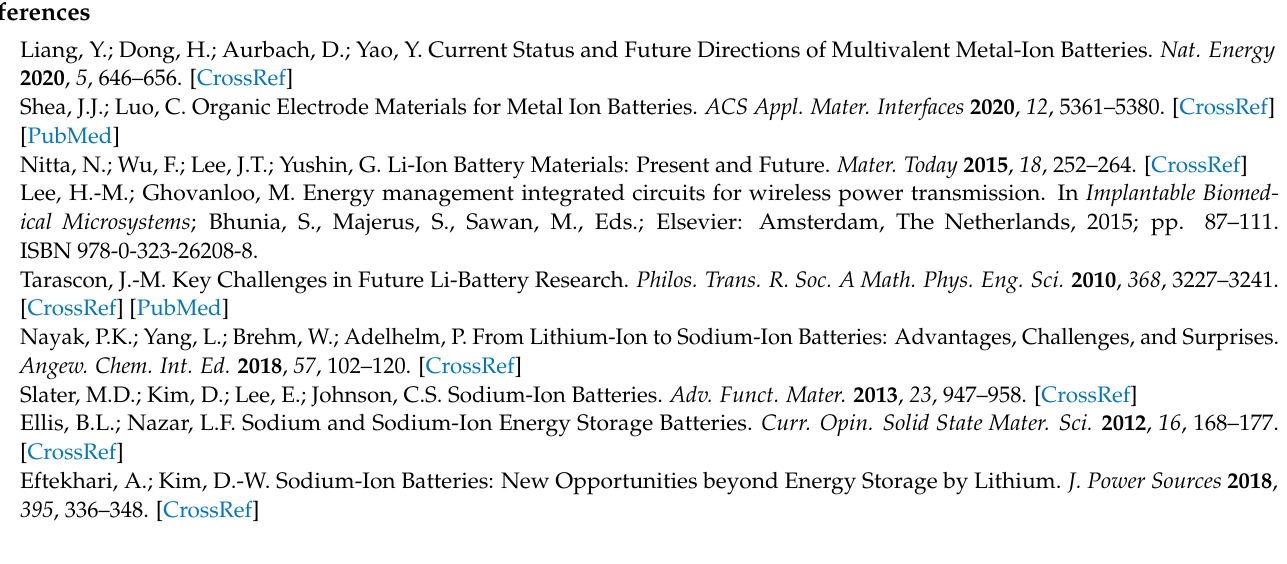
Figure S2: Diffusion energy profiles for Li (blue) and Na (orange) atoms’ diffusion barriers in different considered directions for A’-MoS 2